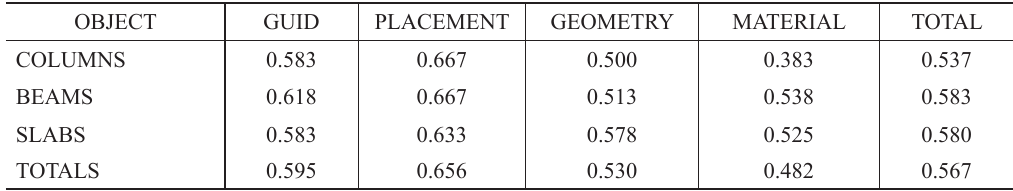
Table 1. Results from the first experiments